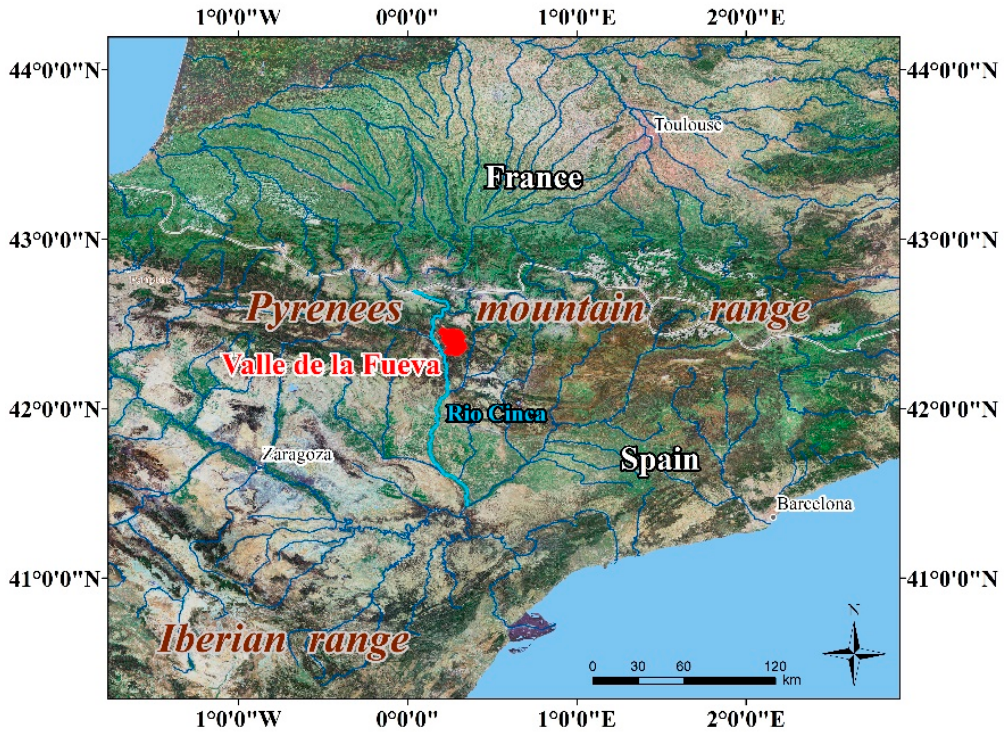
Figure 1. Imagery of the Pyrenees region showing the location of the Valle de la Fueva drainage basin and the course of its main river Río Cinca.